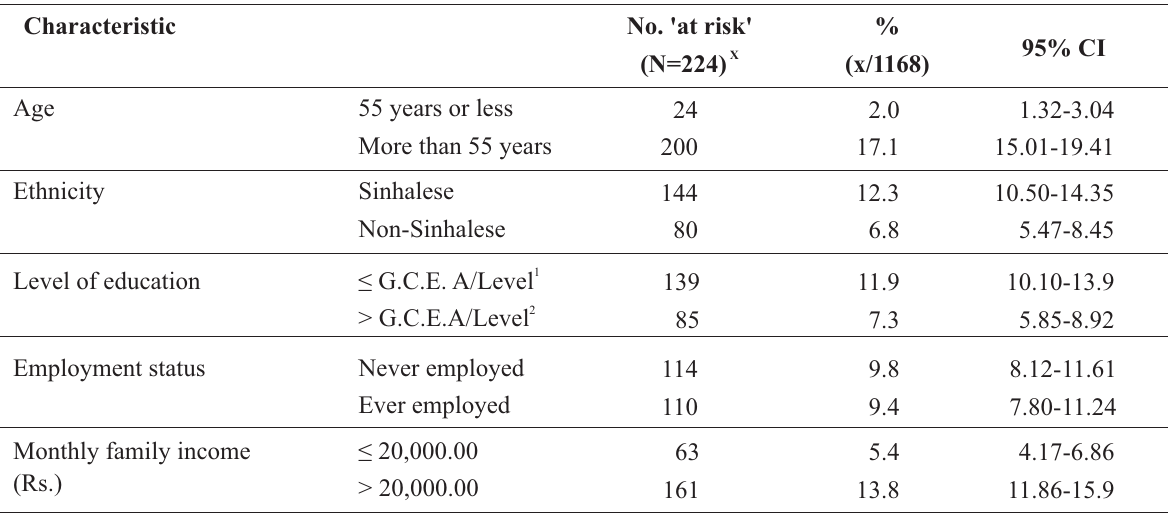
Table 4: Prevalence of women 'at risk' for developing endometrial carcinoma among the study population for selected socio-demographic characteristics